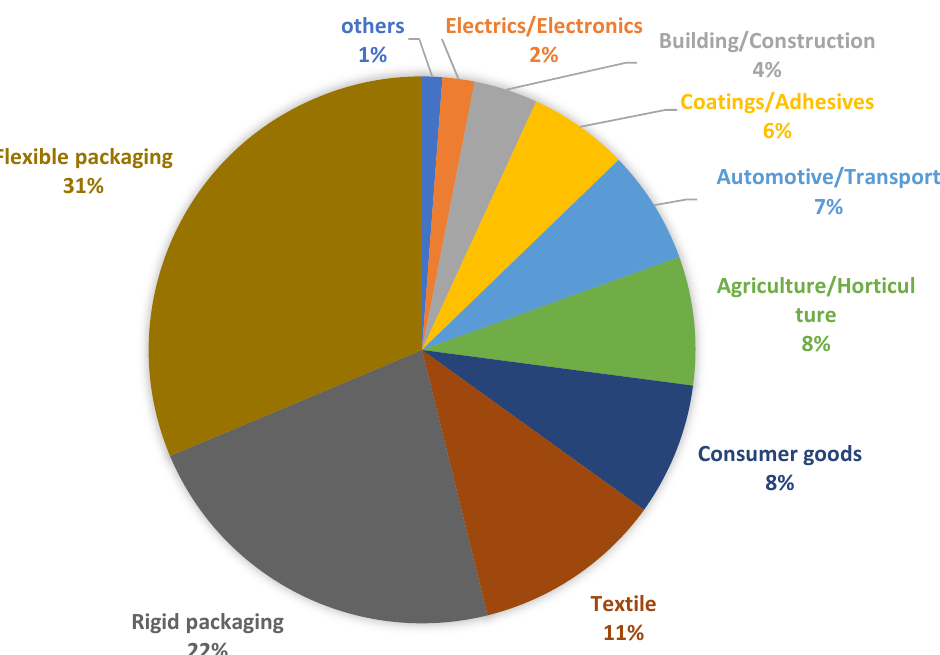
Figure 5. Market segments for bio-based plastics.